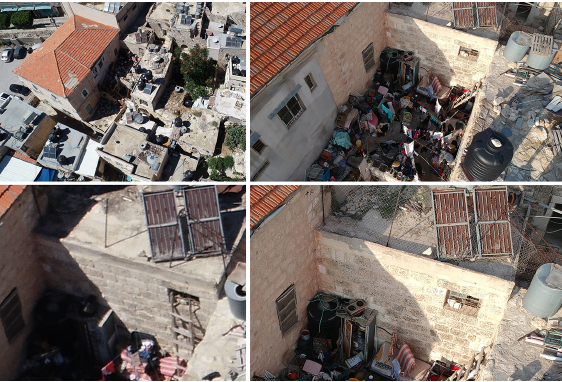
Figure 10: The different quality of the pictures from DJI Phantom 4 Pro (on the left) and DJI Spark (on the right).